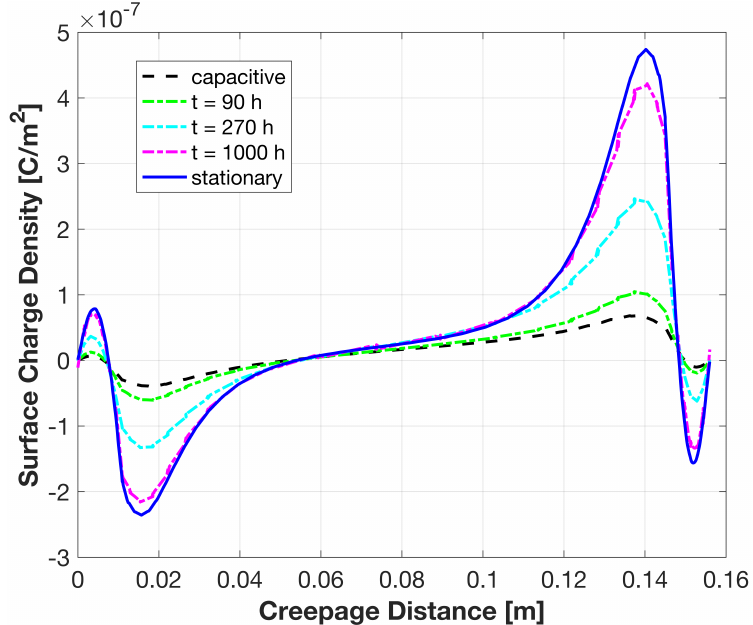
Figure 4. Simulated initial (capacitive) and stationary (resistive) surface charge accumulation along the creepage distance of epoxy insulator. The transient behavior at specified instants of time: t = 90 h, t = 270 h and t = 800 h, is also